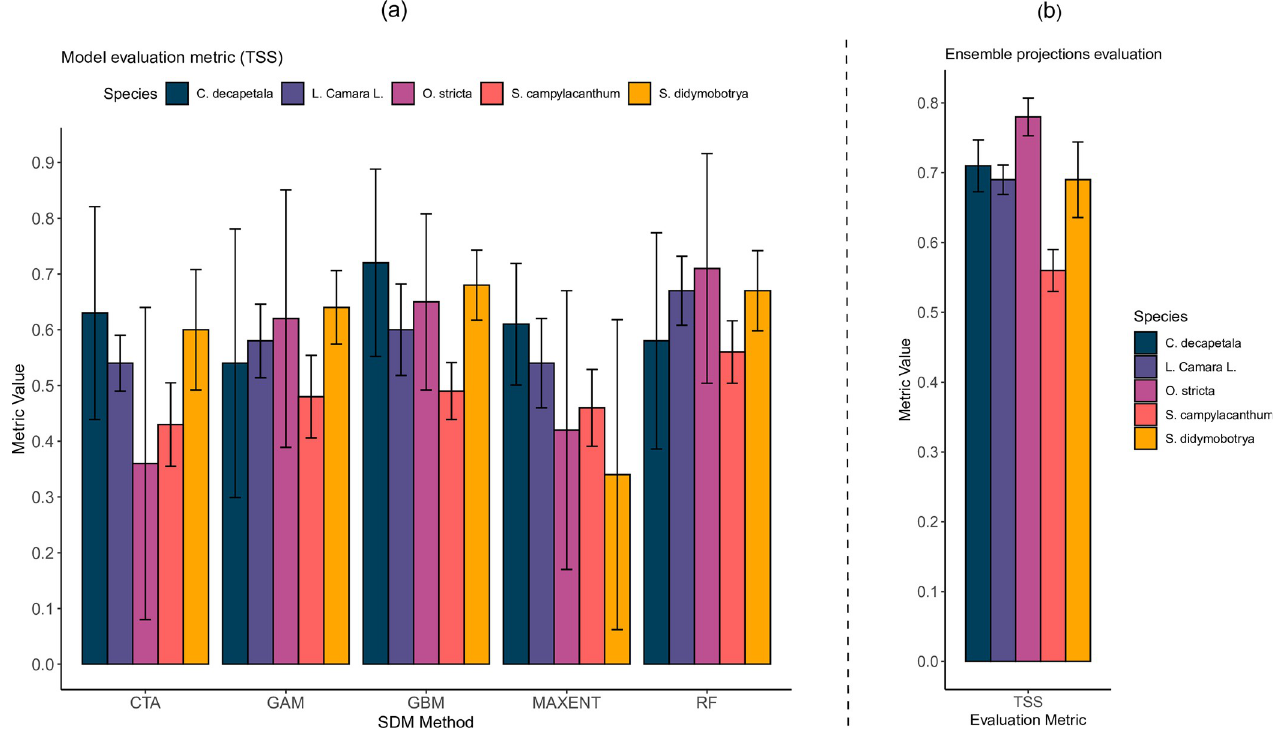
Fig 2. Bar graph plots of evaluation metric accuracies for the study species per ENM method and ensemble binary predictions.